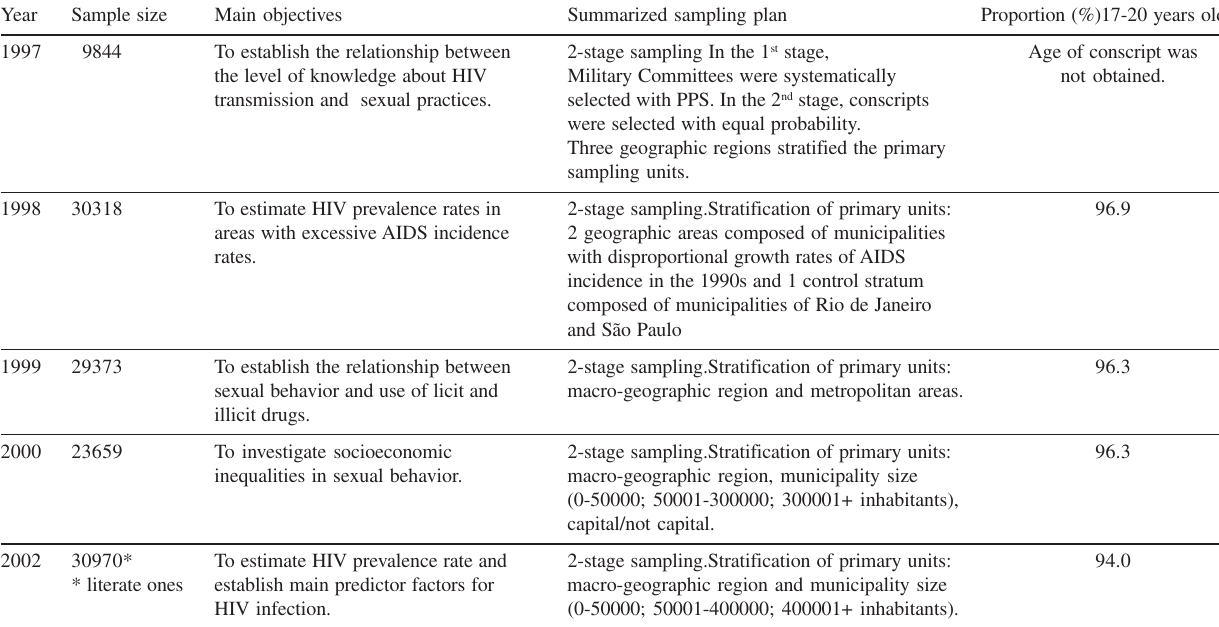
Table 1 - Summary descriptions of sampling plans and objectives of the surveys. Brazilian Army conscripts,